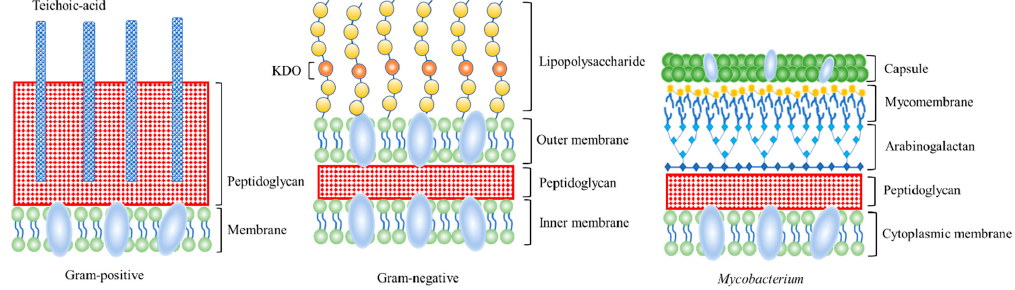
Figure 3. Cell wall structure of Gram-positive bacteria, Gram-negative bacteria, and Mycobacterium .